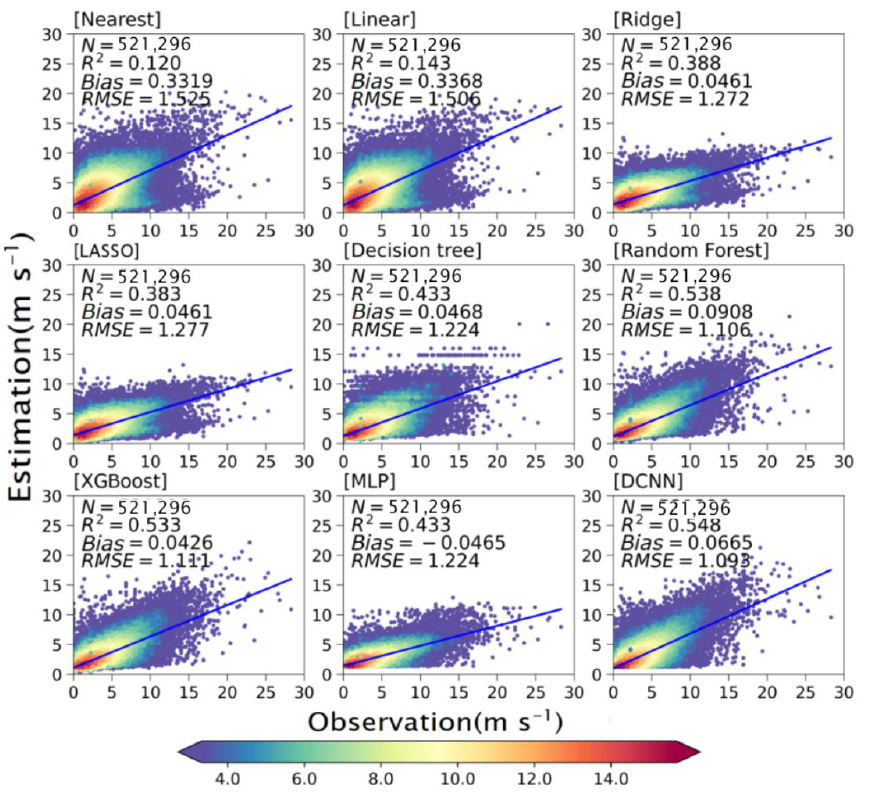
Figure 1. Scatter plots of wind speeds estimated by all nine grid-to-site conversion models and observed values for the summer test dataset. The value of colorbar is represented log 2 𝑘𝑒𝑟𝑛𝑒𝑙 𝑑𝑒𝑛𝑠𝑖𝑡𝑦 × 100,000 .